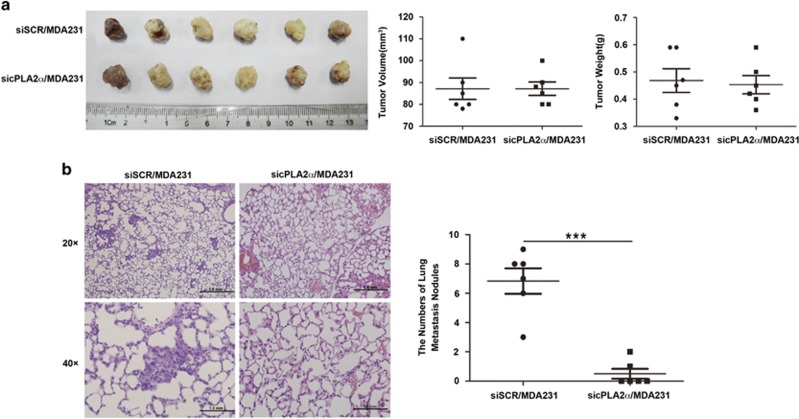
The reduction of breast cancer cell metastatic nodules in response to sicPLA2α was due to impaired metastatic seeding at the metastatic locus in vivo. Tumors from the female nude mice that were orthotopically transplanted with the same number of MDA-MB-231 and sicPLA2α/MDA-MB-231 cells (6 × 106/mouse) into the fat pad (n=6/group), the mice were killed when the tumor volume reached ~1 cm3 (a) the primary tumor volume and weight for two groups and (b) the number of lung metastasis for two groups. Data are represented as the mean±S.D., n=6. ***P<0.001. Scale bar, 1.0 mm